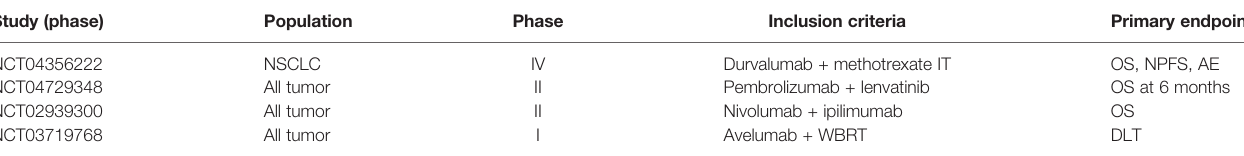
TABLE 2 | Ongoing trials with immune checkpoint inhibitors in patients with leptomeningeal metastasis. Study (phase)